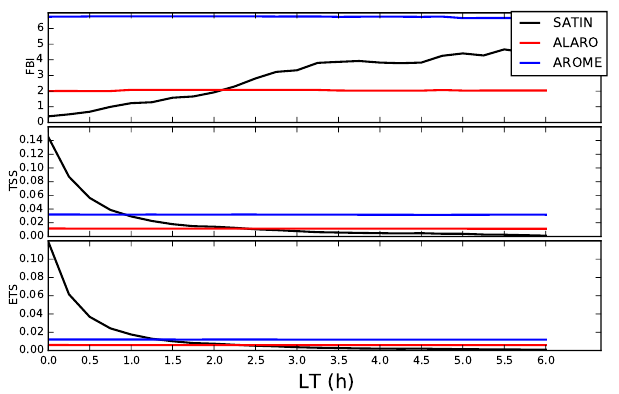
Figure 4. Comparison of pure (translational) nowcasting with NWP: FBI, TSS and ETS averaged over July for ALARO (5km), AROME (2.5km) and SATIN.